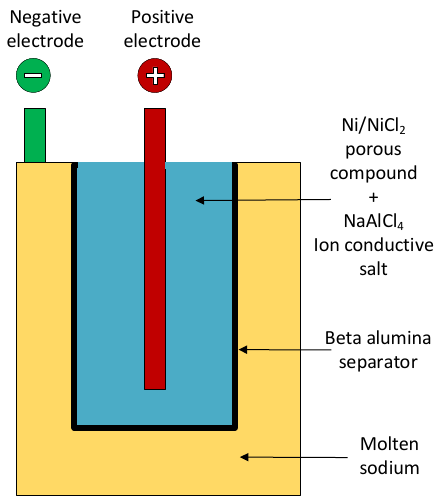
Figure 4. Sodium nickel chloride